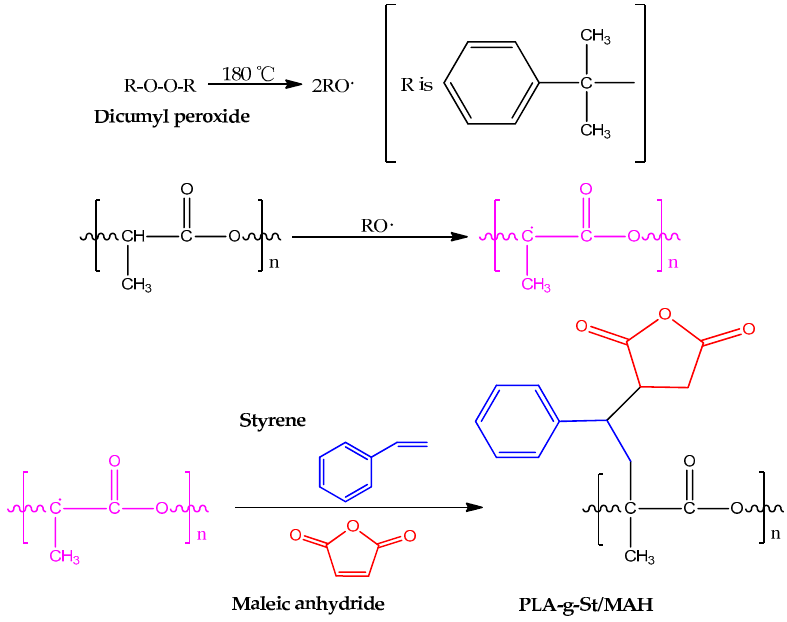
Figure 2. Possible mechanism for melt grafting of MAH onto PLA with St as the comonomer.